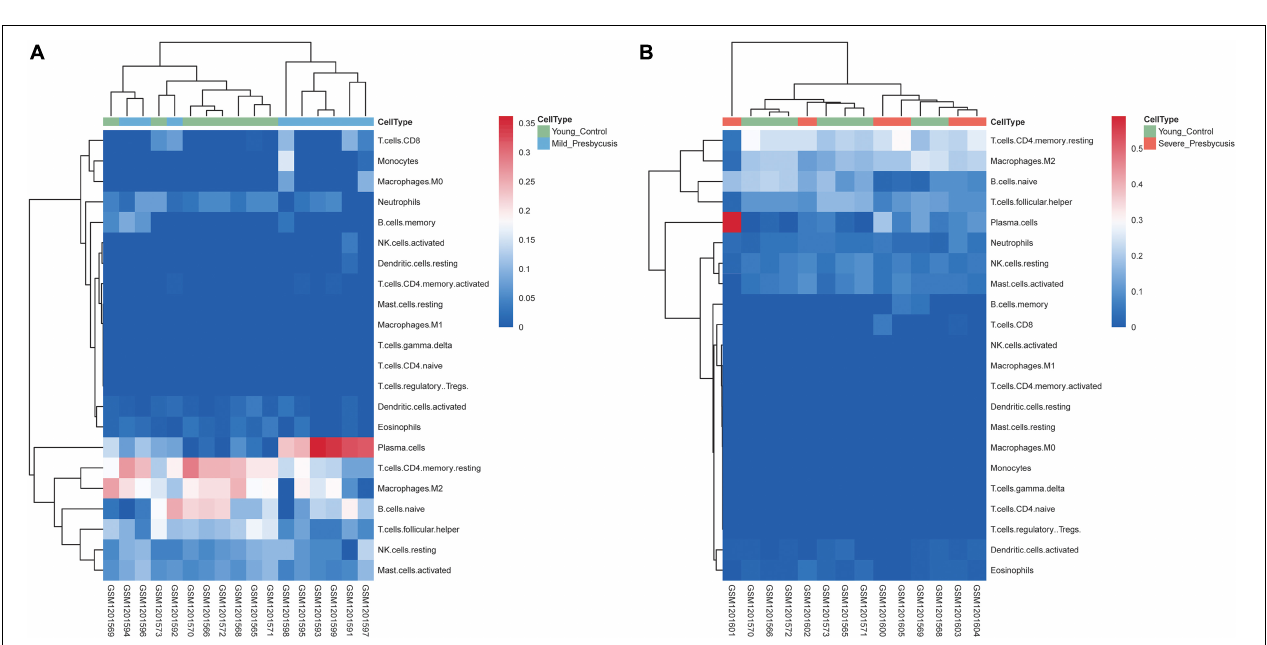
FIGURE 6 | Landscape of immune infiltration in presbycusis. (A) The heat maps of different types of immune cells expression between mild presbycusis and young control group. (B) The heat maps of different types of immune cells expression between severe presbycusis and young control group.